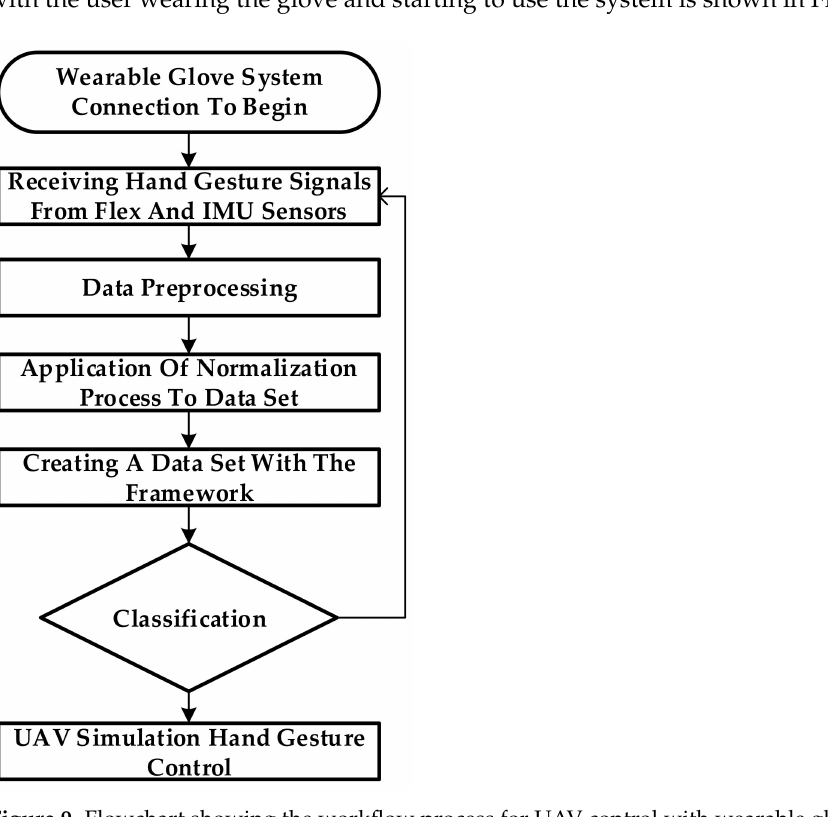
Figure 9. Flowchart showing the workflow process for UAV control with wearable gloves. Under the proposed method, with the help of a control mechanism for the UAV flight guidance process, 25 different basic gestures were realized with the two gloves. The 25 movements were created by combining five different gestures from the right and left hands. For the 25 different gestures, 49,000 datasets, each consisting of 11.2 bytes, were obtained from the sensors. After this data set normalization process was applied, the hand gestures were classified using MATLAB’s Classification Learner ToolBox and the decision tree (DT), naïve Bayes (NB), support vector machines (SVM), and K-nearest neighbor (KNN) classification methods; moreover, class was defined. The accuracy